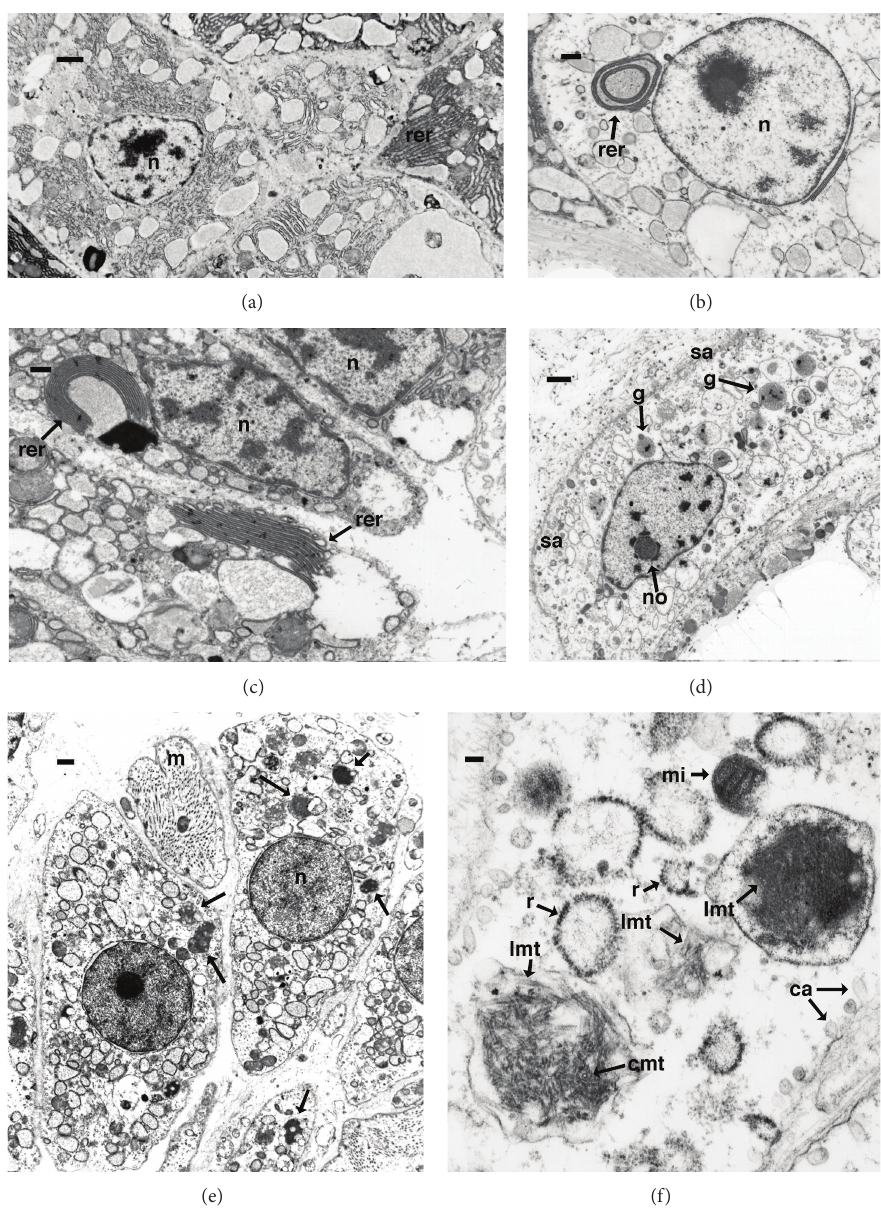
Figure 5: RER and granulate cells in the ink glands of Aplysia juliana ((a)–(d)) and A. parvula ((e) and (f)). (a) In RER cells the rer is closely appressed, only expanding into few vacuoles containing material of medium electron density or occurring as a whorl adjacent to the nucleus (b) or a Golgi-like stack of membranes with inflated tips (c). (d) A granulate cell has numerous dense granules, sieve areas, and a nucleolus. (e) RER cells have vacuoles containing dense material (arrows) appearing as dense granules with light microscopy (and similar in appearance to those in granulate cells). (f) These vacuoles contained aggregations of short, microtubule-like rods. ca, caveolae; Cmt, cross section of microtubule; g, dense granule; Lmt, longitudinal view of microtubule; m, muscle; mi, mitochondrion; n, nucleus; no, nucleolus; r, ribosome; rer, rough endoplasmic reticulum; sa, sieve area. Scale bars: (a)–(e) = 10 𝜇 m; (f) = 100